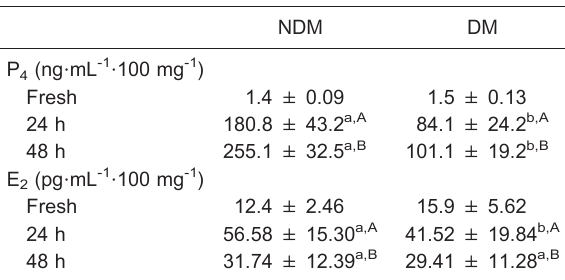
Table 2. Concentrations of progesterone and 17 b -estradiol in media of cultured bovine